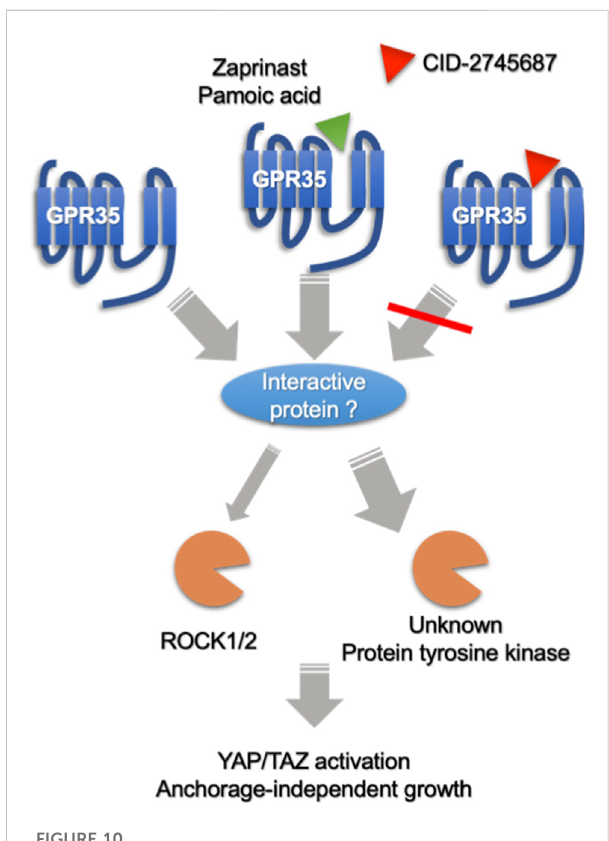
FIGURE 10 Speculative summary on the mechanism of GPR35 and its antagonist on CRC cells. GPR35 expression promotes anchorage- independent growth of CRC cells by enhancing YAP/TAZ activation partly through Rho-GTPase/ROCK1/2 axis, where other unknown protein tyrosine kinase may also participate. Furthermore, GPR35 activity modulates YAP/TAZ activity by associating with other proteins or receptors inan agonist-independent manner.Antagonists, like CID-2745687 and ML145, perturb GPR35 to association with interacting protein, exhibiting an inhibitory effect on YAP/TAZ activity. On the other hand, Agonists, like zaprinast and pamoic acid, do not further promote GPR35-mediated YAP/TAZ activity but can compete with CID-2745687, attenuating the inhibitory effect of